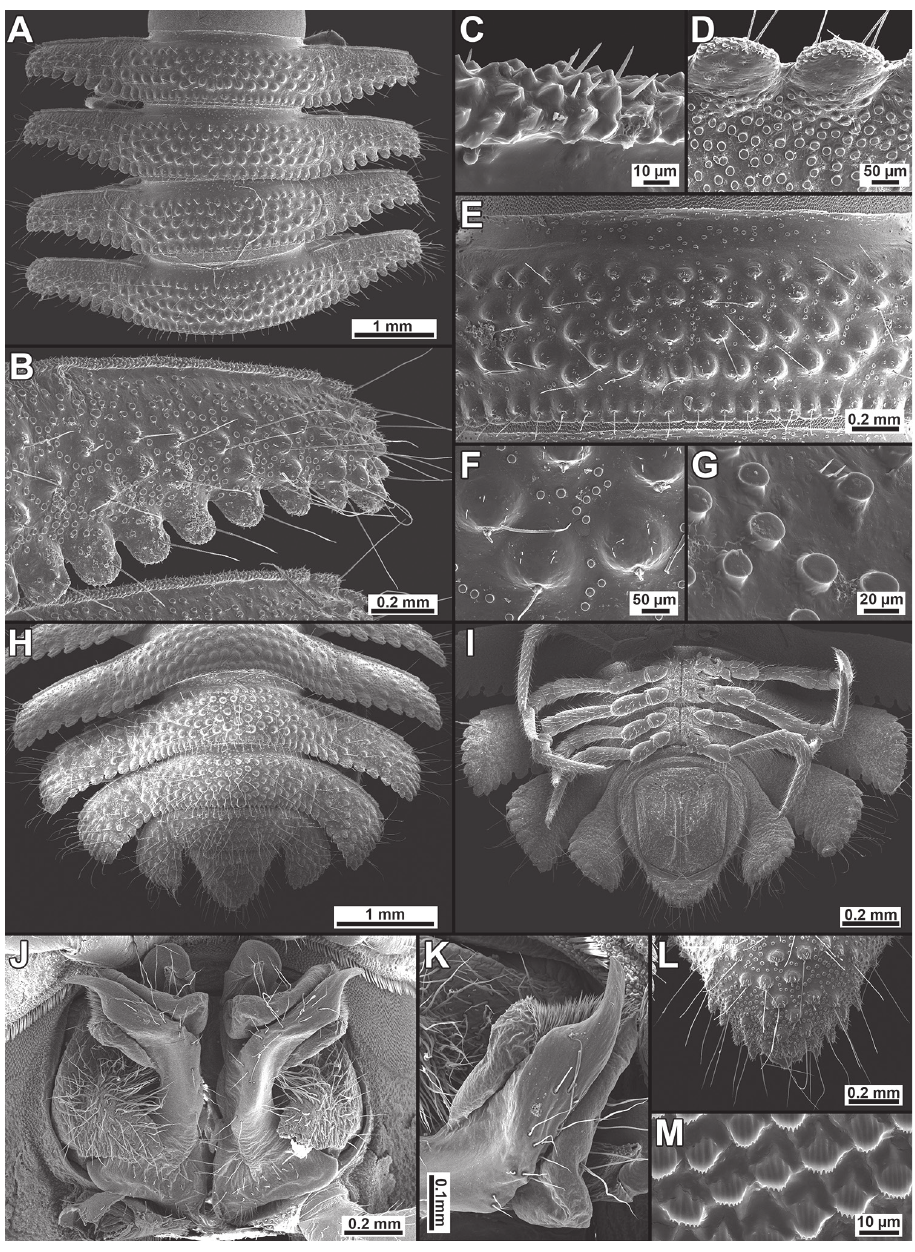
Figure 3. Trichopeltis sutchariti sp. n., ♂ paratype. A segments 9–12, dorsal view B paraterga of segment 10, dorsal view C anterior edge of paraterga, dorsal view D paraterga, lateral view E metaterga of segment 9, dorsal view F setigerous tuberculations on metaterga, dorsal view G spherical knobs on metaterga, dorsal view H, I posterior part of body, dorsal and ventral views, respectively J, K gonopod, ventral and sublateral views, respectively L enlarged epiproct, dorsal view M enlarged prozona, dorsal view. SEM without metallic